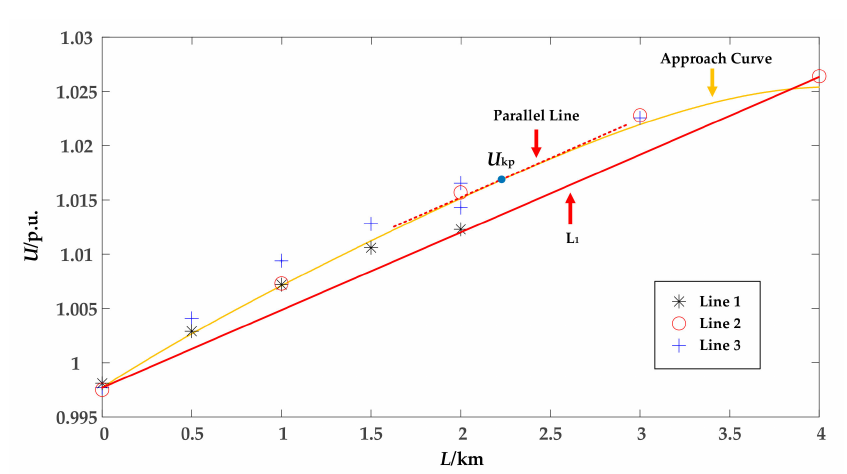
Figure 9. The voltage distribution of all wind